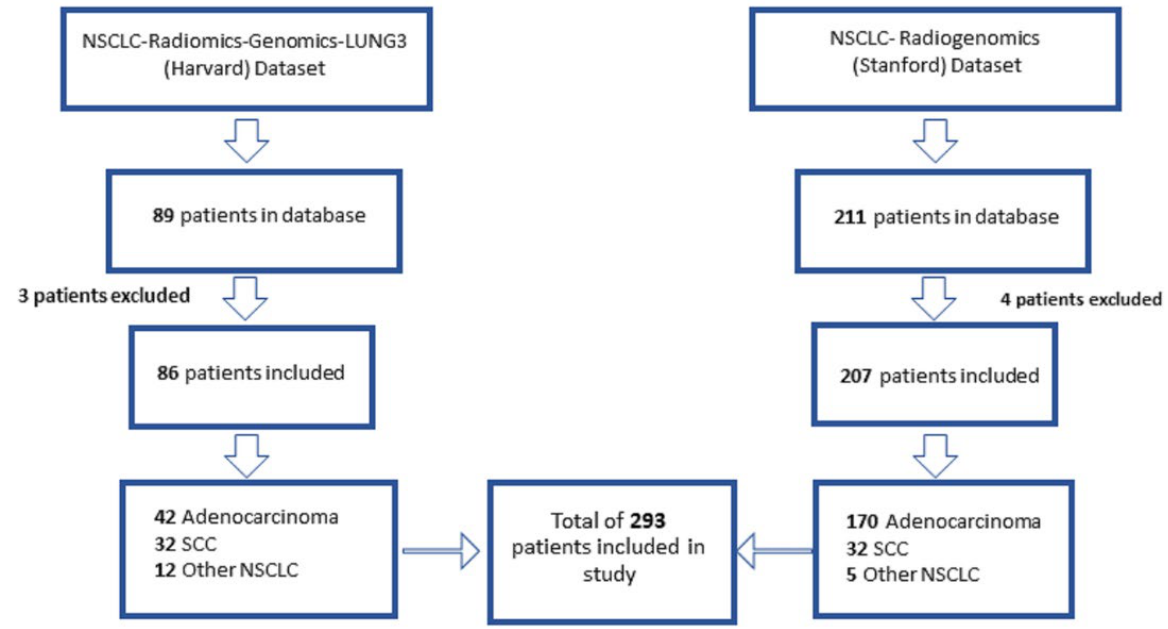
Figure 2. Number of patients included in study. Two publicly available datasets were analyzed in the study, the NSCLC- Radiomics-Genomics-Lung3 (Harvard) dataset and the NSCLC-Radiogenomics (Stanford dataset). Eighty-nine patients and 211 patients are part of the Harvard and Stanford datasets, respectively. A total of 3 patients were excluded from the Harvard dataset and 4 patients were excluded from the Stanford dataset due to lack of available data. Tumor types consisted of adenocarcinoma (Adeno), squamous cell carcinoma (SCC), and other types of NSCLC. A total of 293 patients were segmented as part of the study. Table 2. Clinical and demographic data including age, race, type of NSCLC, EGFR, and KRAS receptor status, and smoking status for collected patients NSCLC-Radiogenomics (Stanford) is pre- sented.